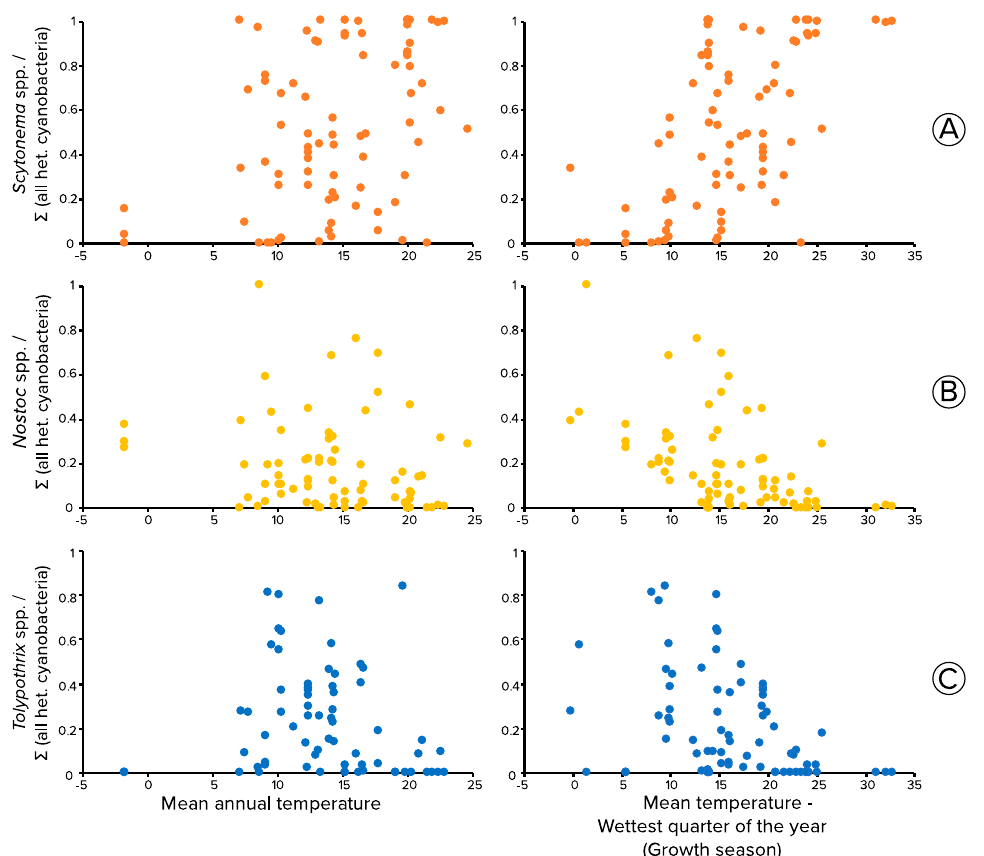
Figure 4. Proportion of sequence reads assignable to Scytonema spp. ( A ; orange), Nostoc spp. ( B ; yellow), and Tolypothrix spp. ( C ; blue) to those assignable to all heterocystous (Order Nostocales) cyanobacteria, in 16S rRNA molecular survey datasets, as a function of climate temperature indicators. Data are from biocrust communities surveyed at 84 locations around the world (see Table S4). Each dot represents a different location.